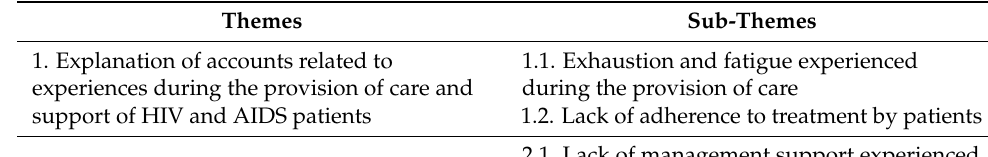
Table 1. Summary of themes and